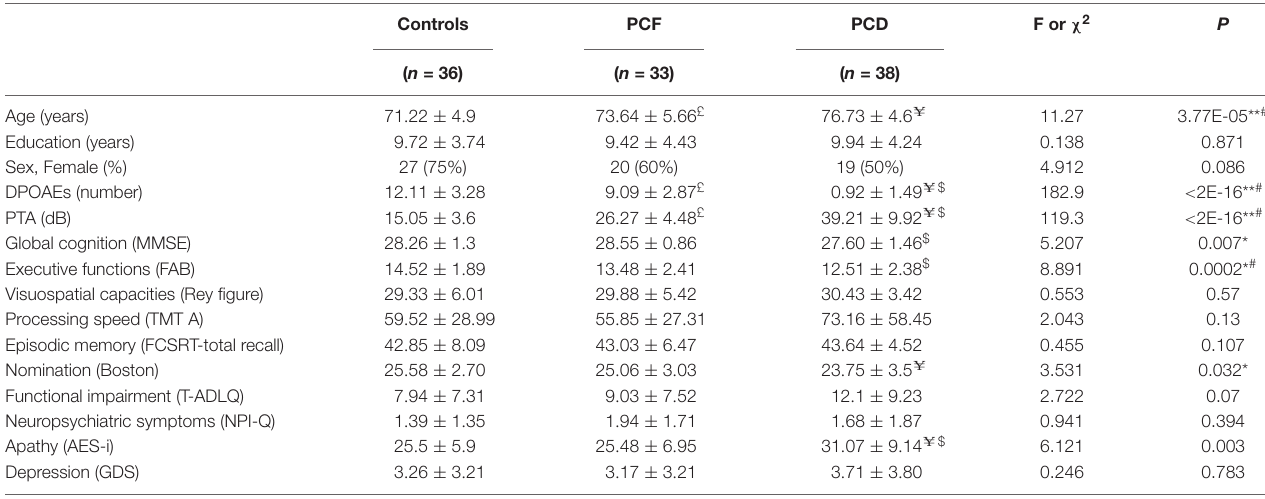
FIGURE 1 | Poisson regression between apathy symptoms and cochlear function. A significant Poisson regression, including age, gender, and education, was obtained between apathy and the number of detectable DPOAE in both ears [ β = –0.015 ( ± 0.003), z = –4.16, p = 3.18e-05 # , R 2 D = 0.17]. Black indicates actual observations. Red dots correspond to the model’s prediction, correcting for age, gender, and years of education. The Poisson regression including only DPOAE, without age, gender, or years of education, accounts for 11% of variance depicted as a red line [ β = –0.016 ( ± 0.003), z = –4.99, –0.28, p = 5.8e-07 # , R 2 D = 0.11]. TABLE 2 | Demographic, audiological, and cognitive comparisons across hearing status